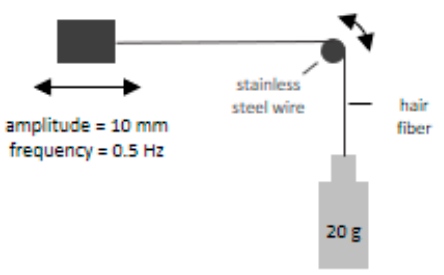
Figure 1. Flexabrasion assembly used for hair fiber mechanical